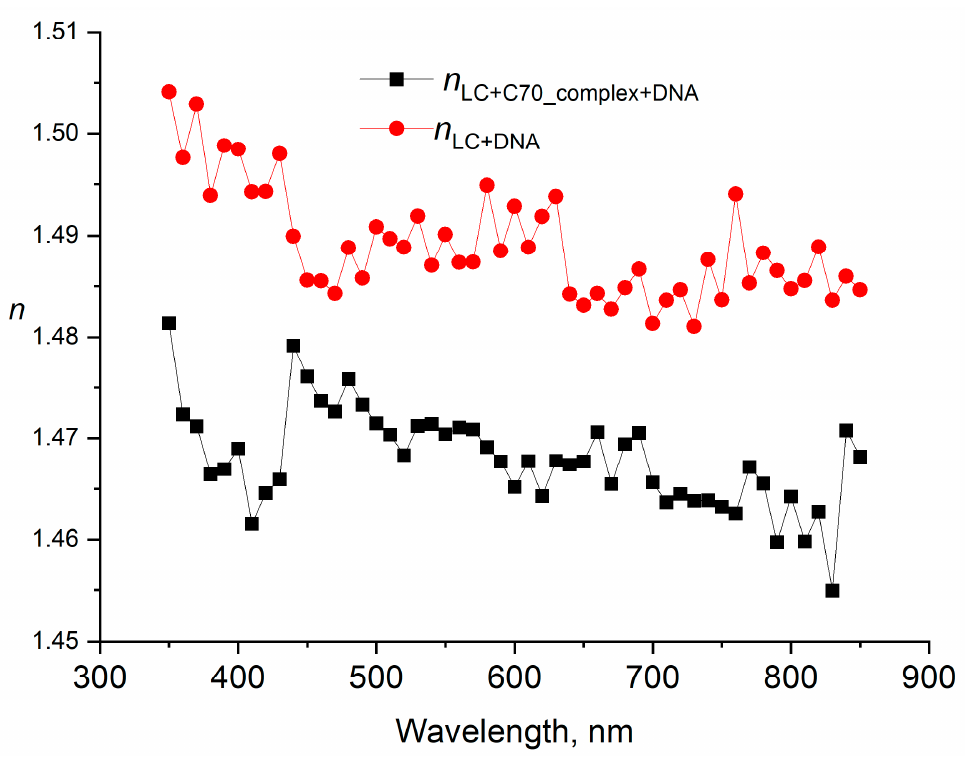
Figure 2. The linear refractive index versus the wavelength for the nano-objects doped materials (dark curve), for the LC doped with the bio-objects doped based on the DNA (red curve). Analyzing the data shown in Figure 2 it should be mentioned, that classical ellipsom- etry method can correlate with the laser-induced change of the refractive index. Really, the spectral dependence of the refractive index measured for the liquid crystal mesophase doped with different CTC based on the nano- and the bio-particles testify the increase of the refractive index in the bio-objects doped LC mixture in comparison with the nano- doped one.